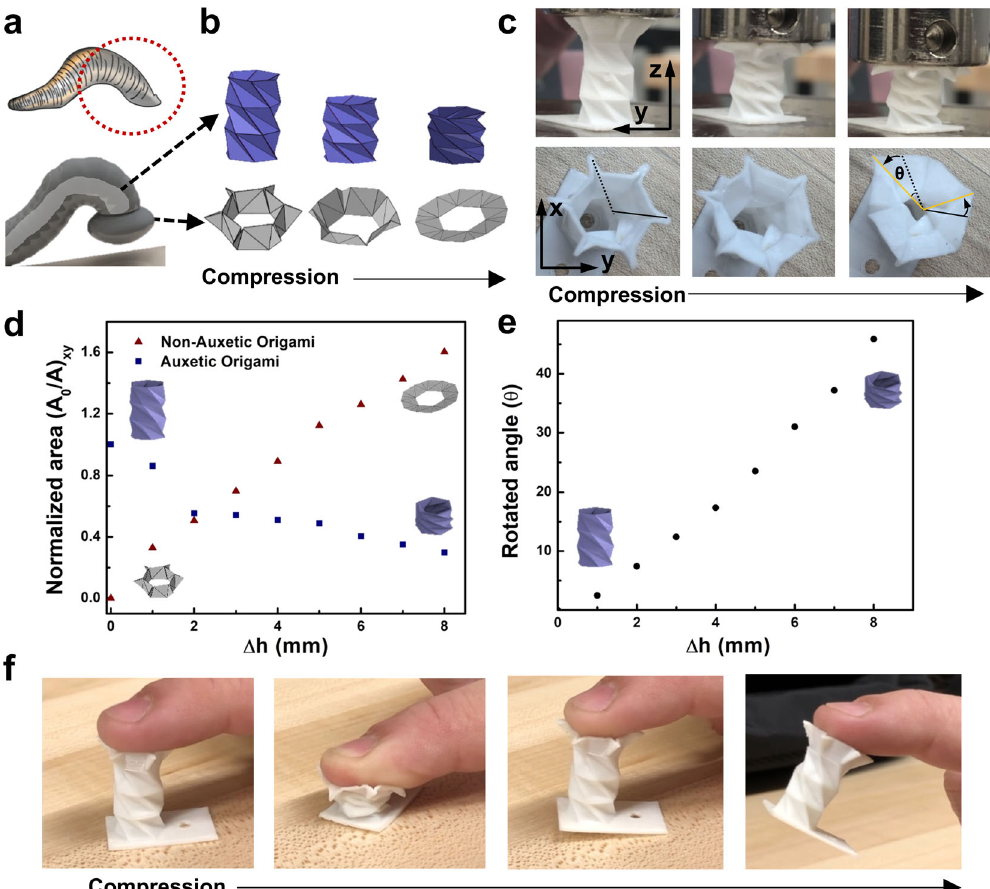
Fig. 2 The mechanical behavior of the designed LIO structure. a Schematics of the posterior sucker and body of leech and b their corresponding leech-inspired non- and auxetic origamis with the folding features under compression. c The actual images of 3D printed LIO under compression, side views (top), and top views (bottom). d The normalized area changes of LIO. e Rotated angles depending on compressed distances. f Representative photos of the adhesive performance of the designed and Supplementary Fig. 1. When angular designs of triangular patterns are tailored on origami structures, as shown in Fig. 3a, the mechanical properties of the structure are adaptable. In this parametric study, we compared the responses of three different parameters at different angles: (1) Poisson ’ s ratio, (2) rotation angle, and (3) elastic modulus of the origami structures 26,27 .